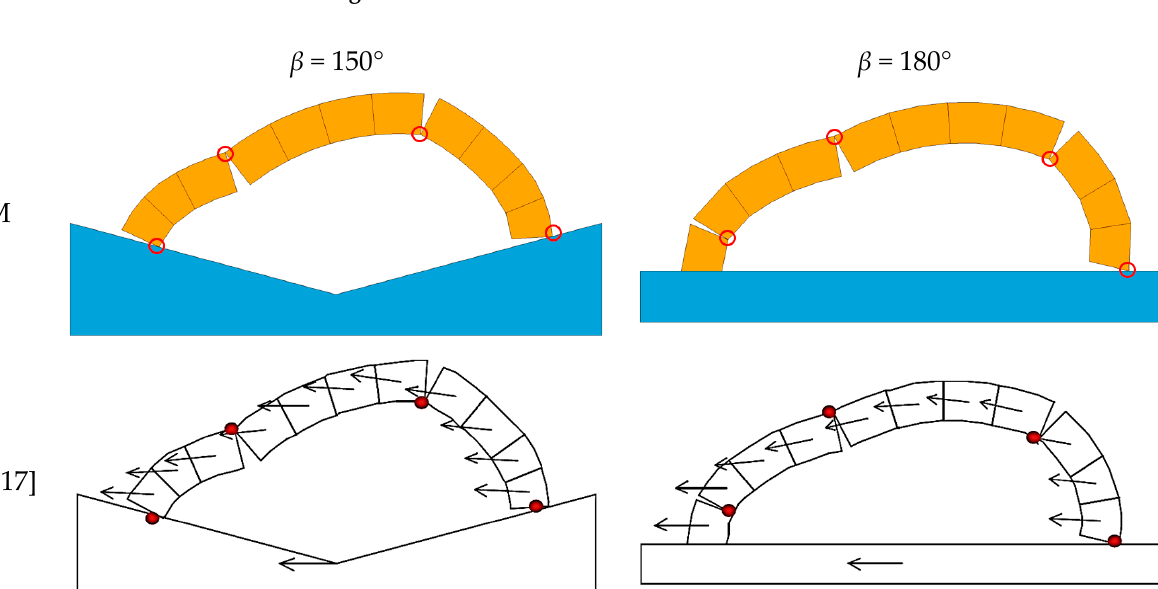
Figure 7. Failure modes of basket-handle arches.